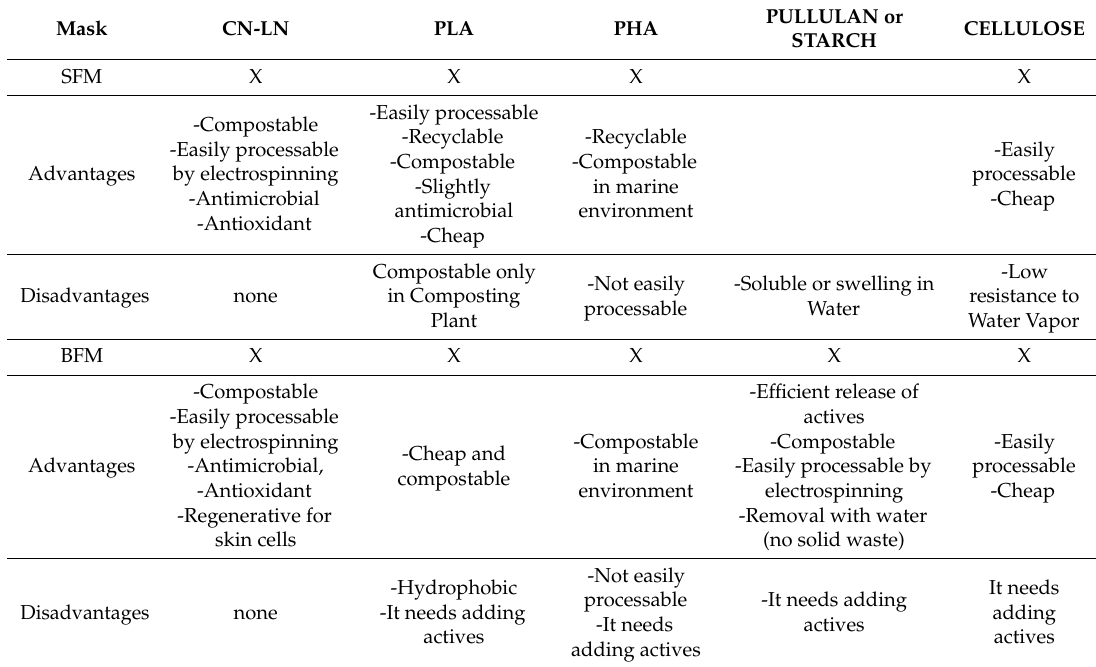
Table 1. Fully renewable and biodegradable polymers highly compatible with skin that can be used in surgery face masks (SFM) or beauty face masks